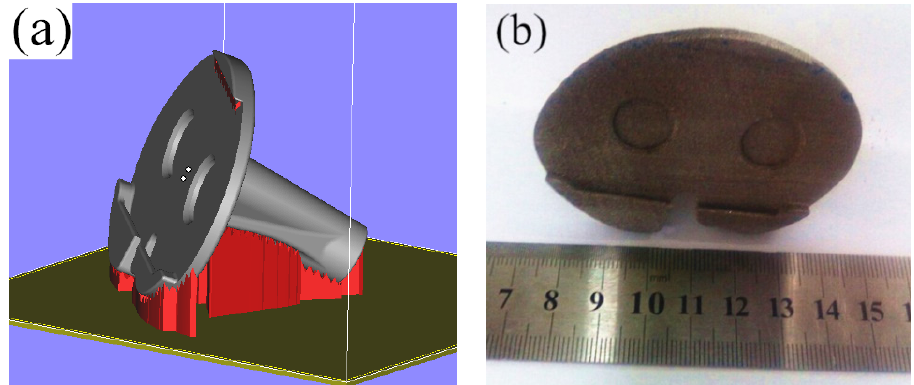
Figure 9. The addition way of the tibial prosthesis support and the effect of SLM molding: ( a ) Flipping of tibial fixed column; ( b ) Post forming effect of SLM.